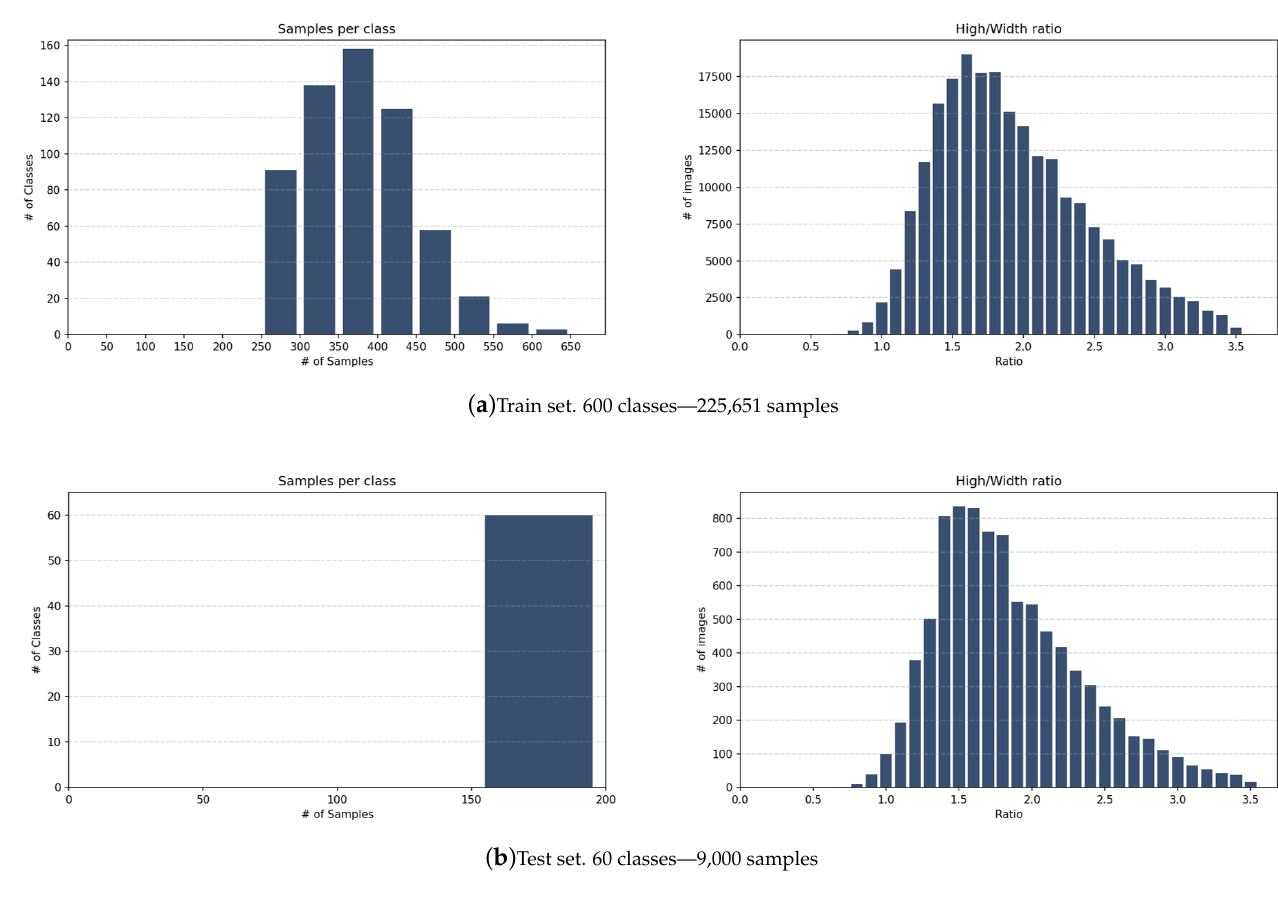
Figure 6. VGGFace-Ear dataset